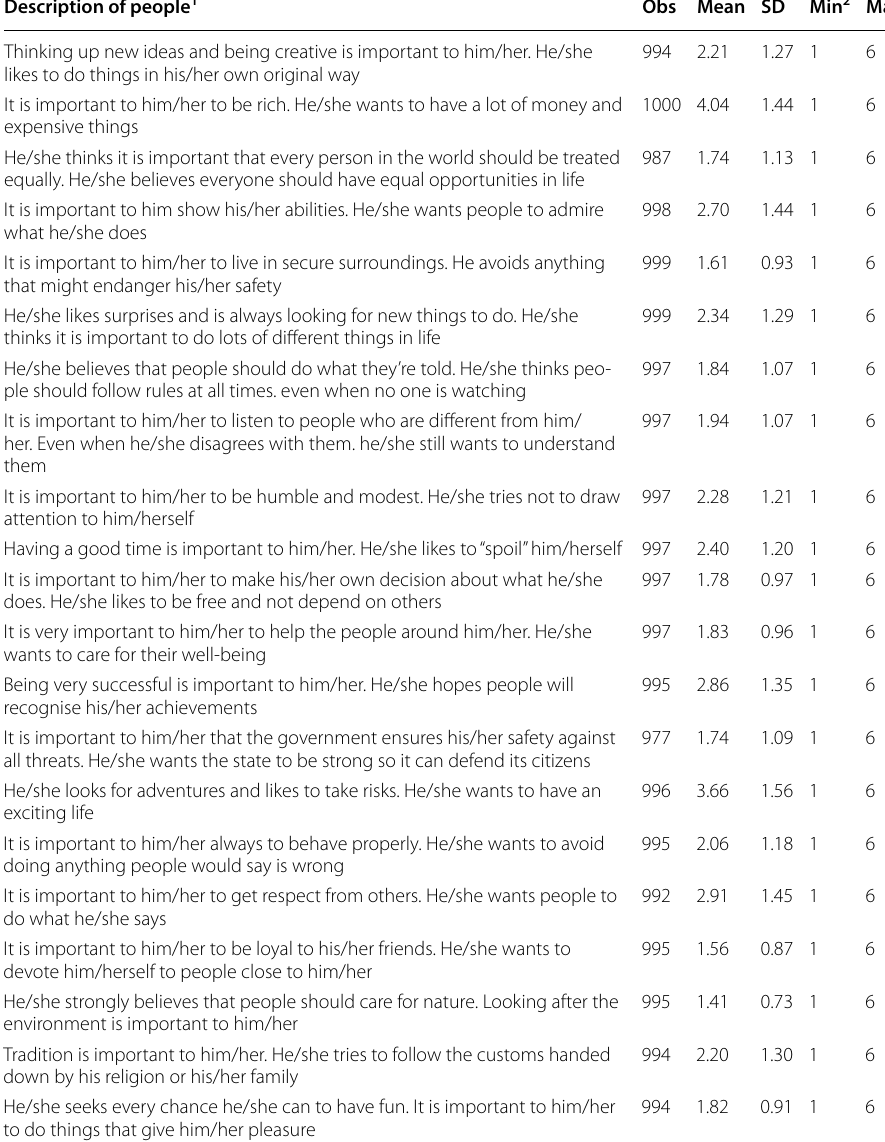
Table 9 The Schwartz portrait values questionnaire and descriptive